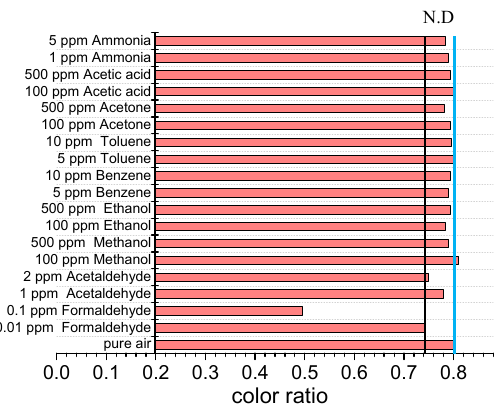
Figure 6. The color ratio of different kinds of gases.